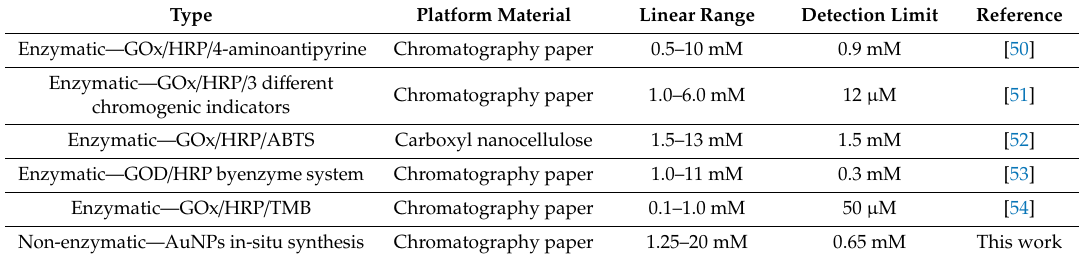
Table 1. Comparison of analytical performance of paper-based colorimetric platforms for glucose level determination.